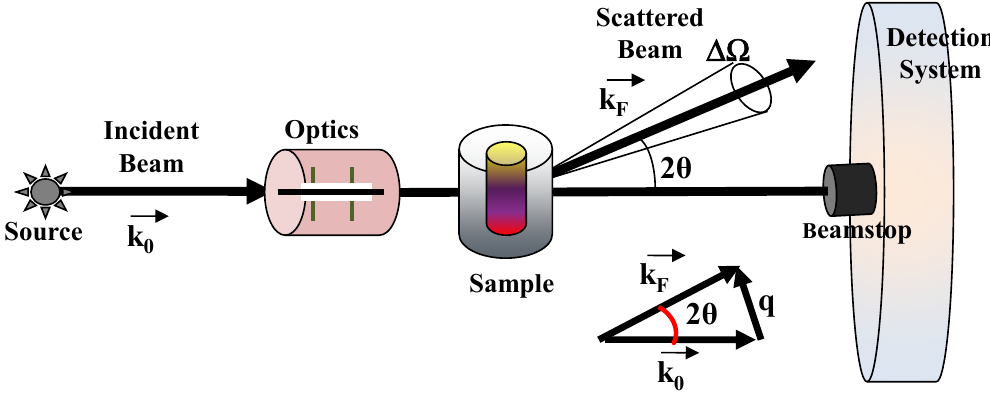
Figure 2. Typical scattering geometry for small angle scattering (SAS) experiments. An incident radiation beam from a neutrons or X-rays source impinging on the material system (sample) under investigation is scattered at a given scattering angle 2 θ and is collected by a proper detection system.